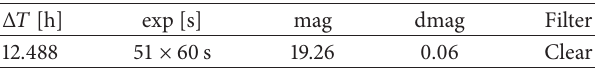
Table 16: GRB 130505A: observing log of BOOTES-2.